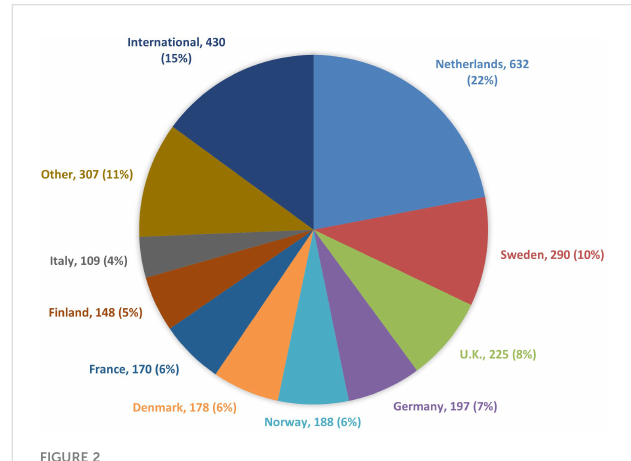
FIGURE 2 Number of articles on cancer treatment by CR country of operation,